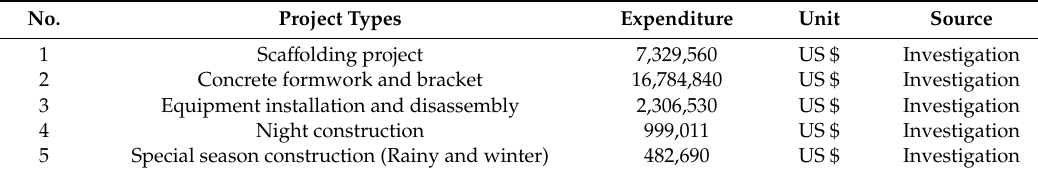
Table 3. Auxiliary engineering costs.